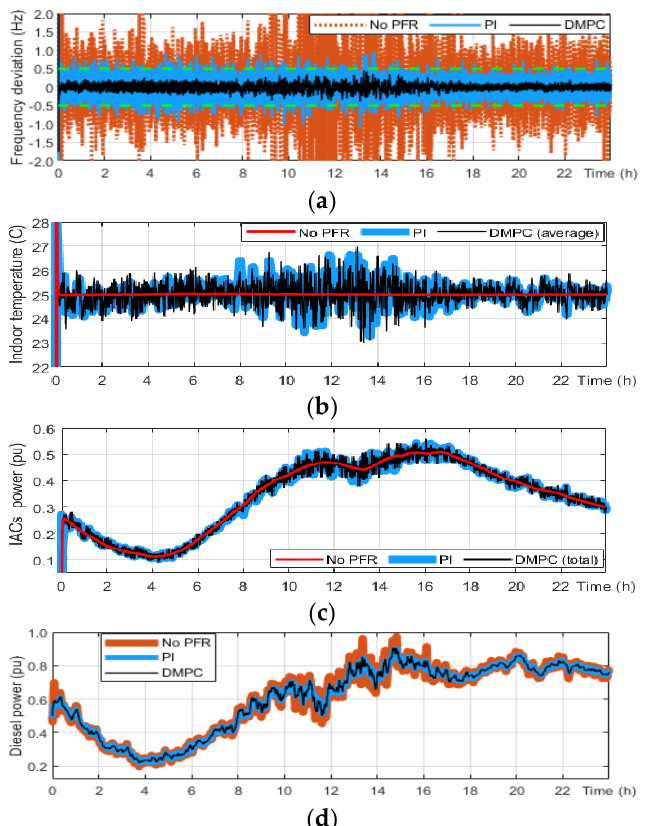
Figure 13. Indoor temperature deviation of the DMPCs for IAC control of case 2.